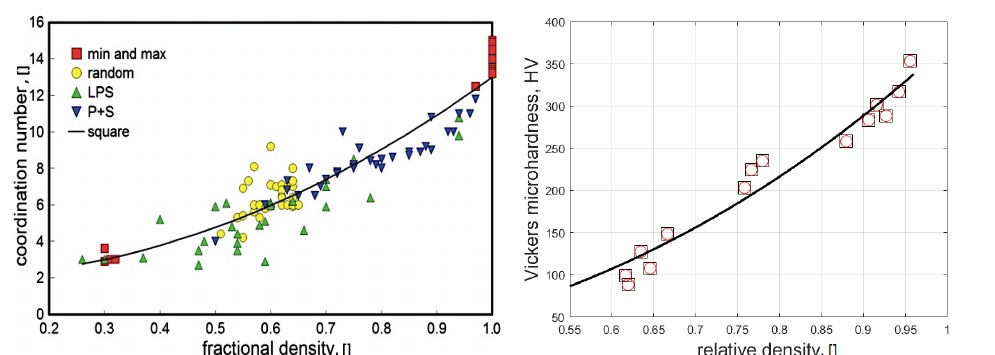
Figure 11. ( left ) Plot of the coordination number versus fractional density using tabulated data for minimum, maximum, random, compacted, sintered, and liquid phase sintered structures, including simulation data. The relation based on the square of the fractional density, according to Equation (15), is given by the solid line. Reprinted with permission from Elsevier and Copyright Clearance Center: Elsevier, Powder Technology [7]. Here LPS represents experimental data obtained using liquid phase sintering, while P+S corresponds to the experimental data obtained by pressing and sintering. “min and max” and “random” represent a mixture of experimental and simulated data. ( right ) Experimental data for microhardness as a function of relative density [6]. The solid line represents the results of fitting by correlations